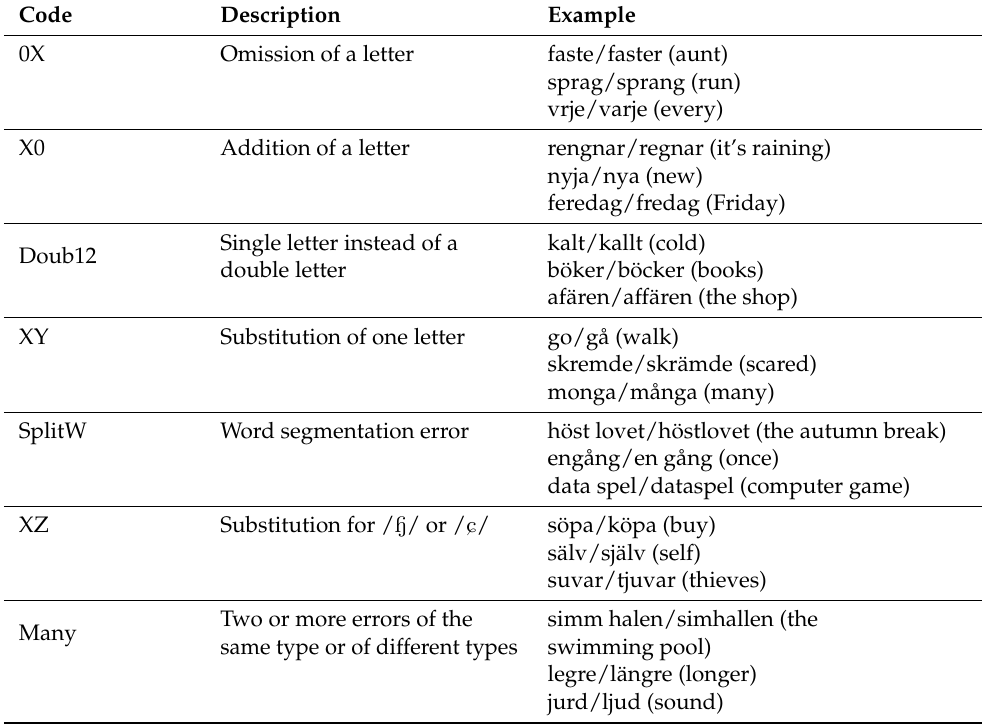
Table 4. List of categories of spelling errors occurring in the final texts.